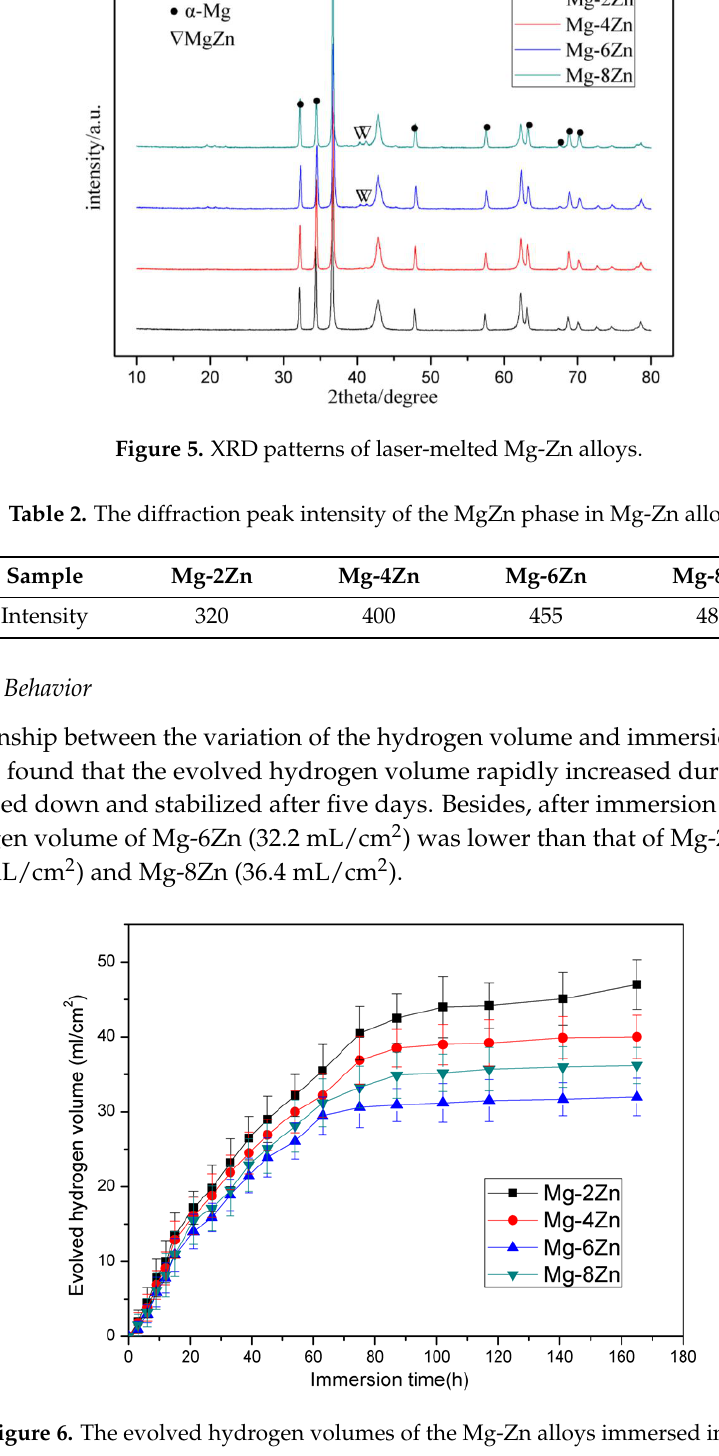
Figure 6. The evolved hydrogen volumes of the Mg-Zn alloys immersed in SBF.